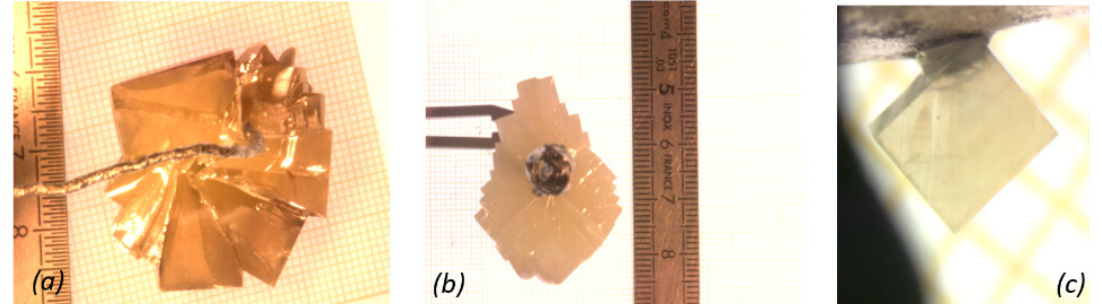
Figure 2. ( a ) Brownish-orange and ( b ) white-cloudy (Li x Na 0 . 52 K 0 . 48 − x )(Nb 1 − x − y Ta x Sb y )O 3 (KNLSTN) centimeter-sized as-grown crystals obtained using top-seeded solution growth technique with different color; and ( c ) millimeter-sized as-grown single crystal on platinum wire exhibiting ferroelectric domains.